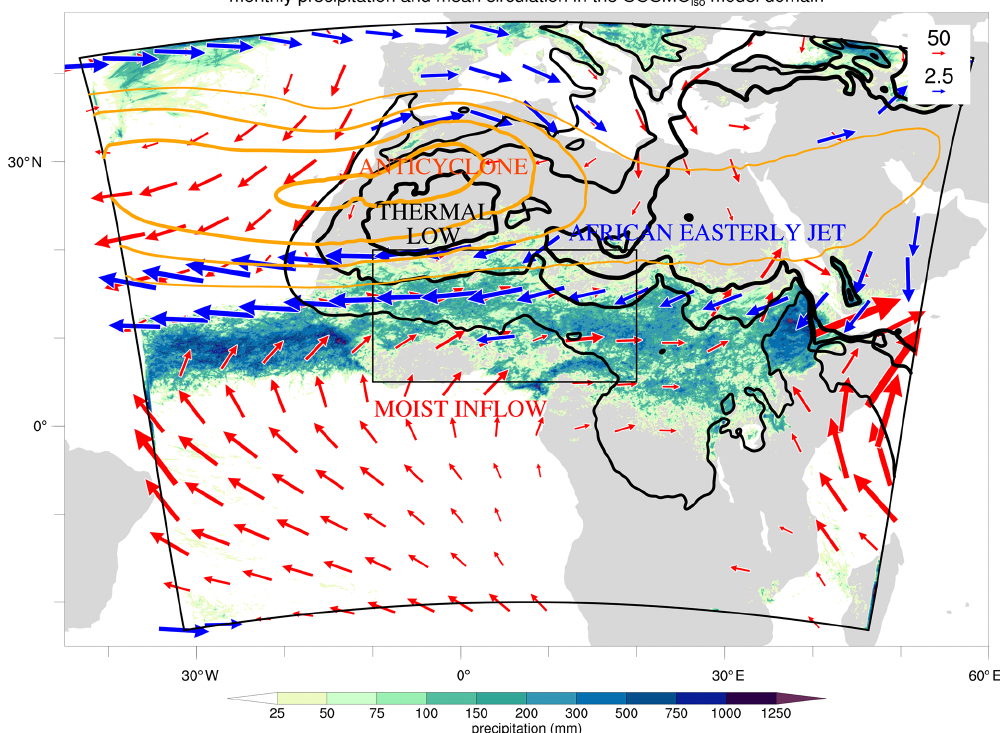
Figure 1. Overview of the West African monsoon (WAM) system and the COSMO iso model domain. Monthly precipitation (mm; shading) and monthly mean circulation patterns (contours) from the convection-permitting COSMO iso simulation at a 7km horizontal grid spacing for July 2016 are shown. The circulation patterns depict the Saharan heat low (mean sea level pressure, hPa; black contours), the mid-tropospheric anticyclone (500hPa geopotential height, gpm; orange contours), the moist air inflow from the eastern tropical Atlantic (vertically integrated horizontal water vapour transport between 1000 and 850hPa; red vectors where its magnitude > 50kgm − 1 s − 1 ), and the African easterly jet (600hPa horizontal wind; blue vectors where the wind velocity > 7ms − 1 ). The COSMO iso model domain (thick black contours) has a rotated grid centred at 13 ◦ N, 7.5 ◦ E. The box in the centre denotes the region of interest (thin black contours; 5–20 ◦ N, 10 ◦ W–20 ◦ E) used for the analysis in Sects. 3.1, 3.3, 4.2, 4.3, and